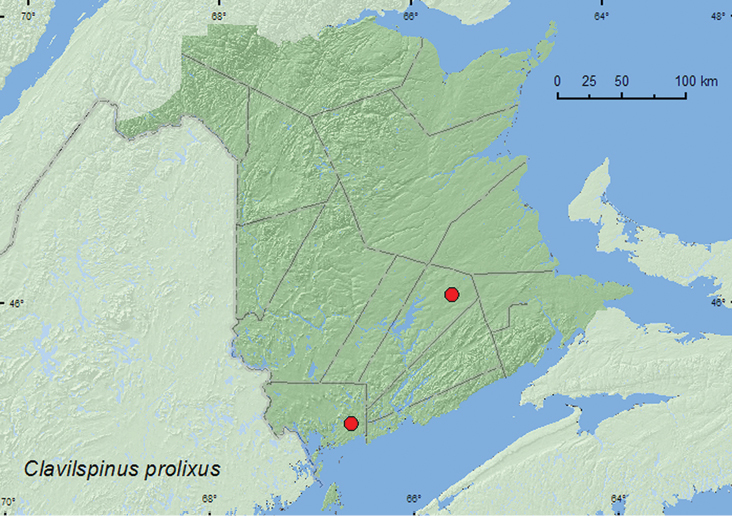
Collection localities in New Brunswick, Canada of Clavilispinus prolixus.